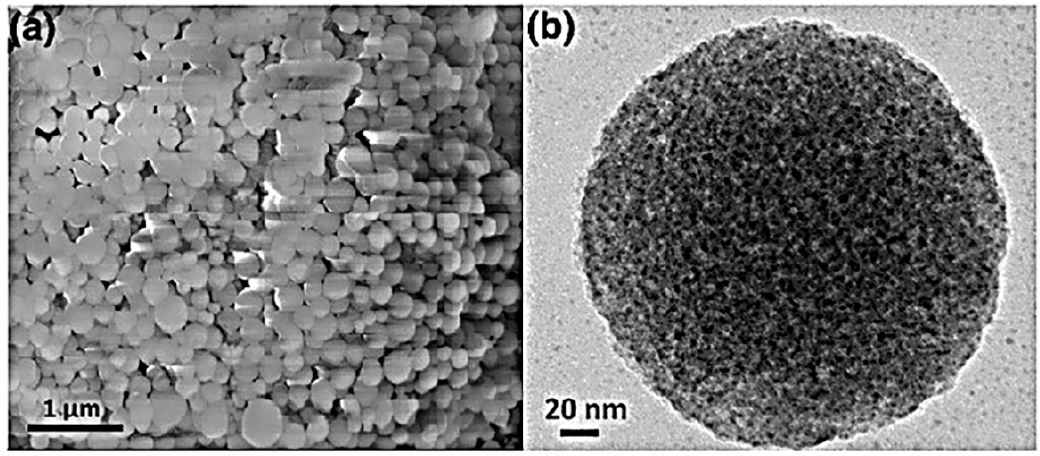
Figure 5. ( a ) SEM and ( b ) TEM micrographs of MPSiO2 particles [2].